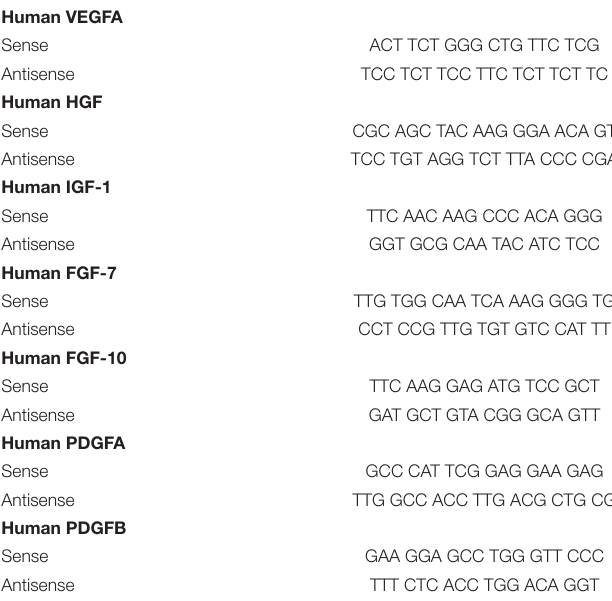
TABLE 1 | Primer sequence for real-time polymerase chain reaction.